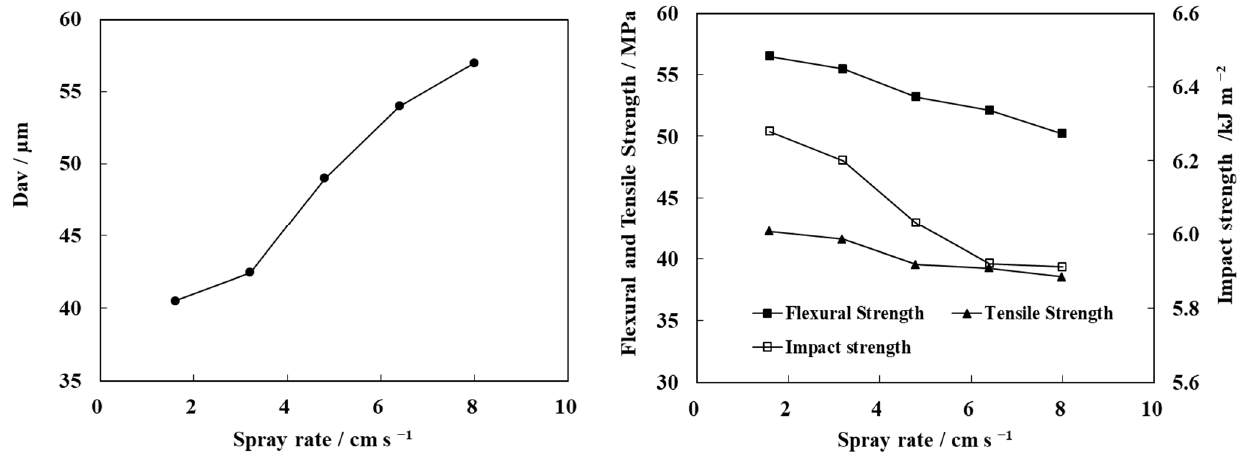
Figure 7. Effect of spray rate on the average particle size of modified N-WPCBs and the mechanical properties of PP/N-WPCB composites.